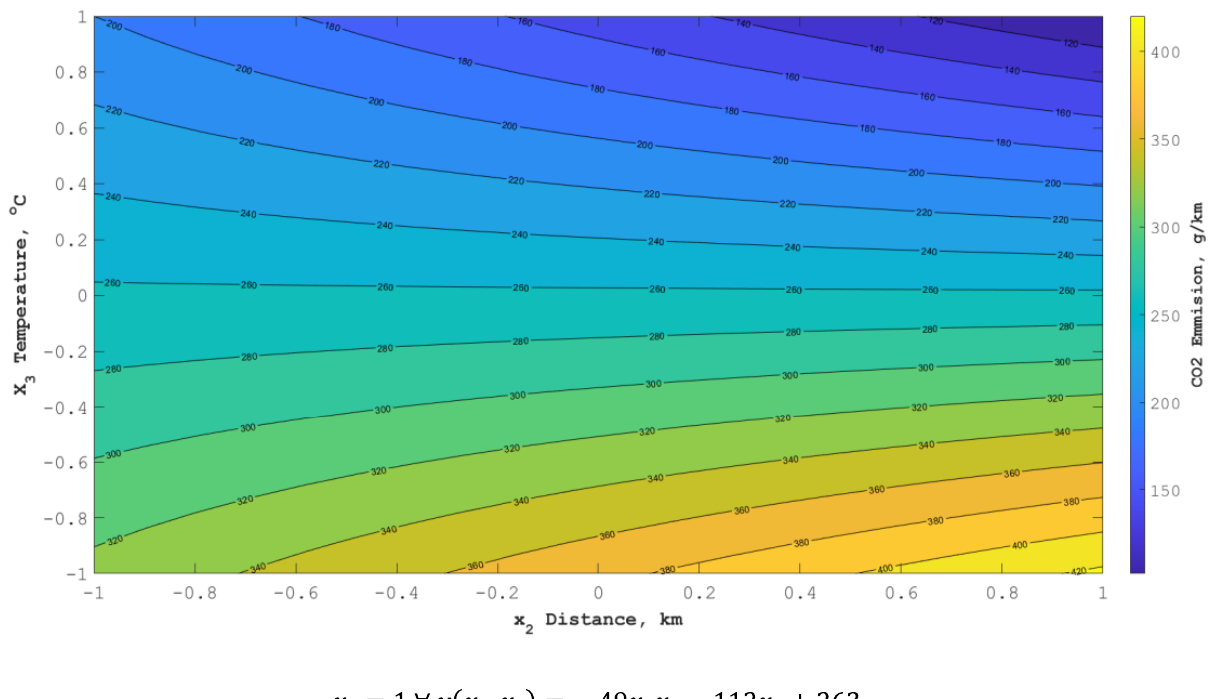
Figure 12. Change in CO 2 emissions depending on the variability of factors x 2 and x 3 for a vehicle (EV) moving for 20 min (x 1 = 0).